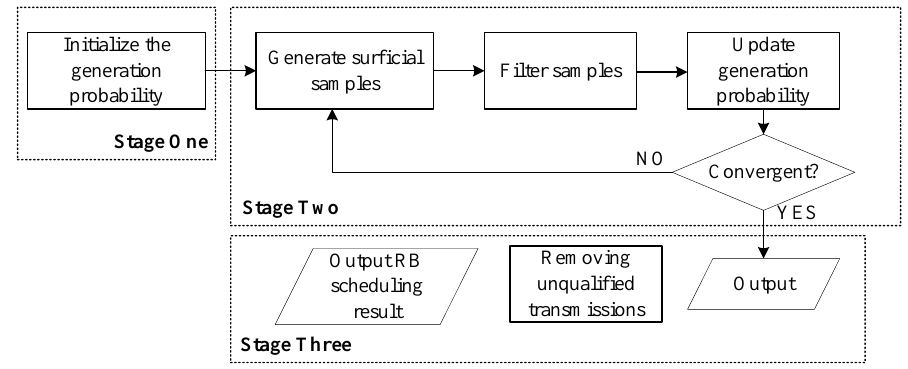
Figure 3. The major principle of the CE